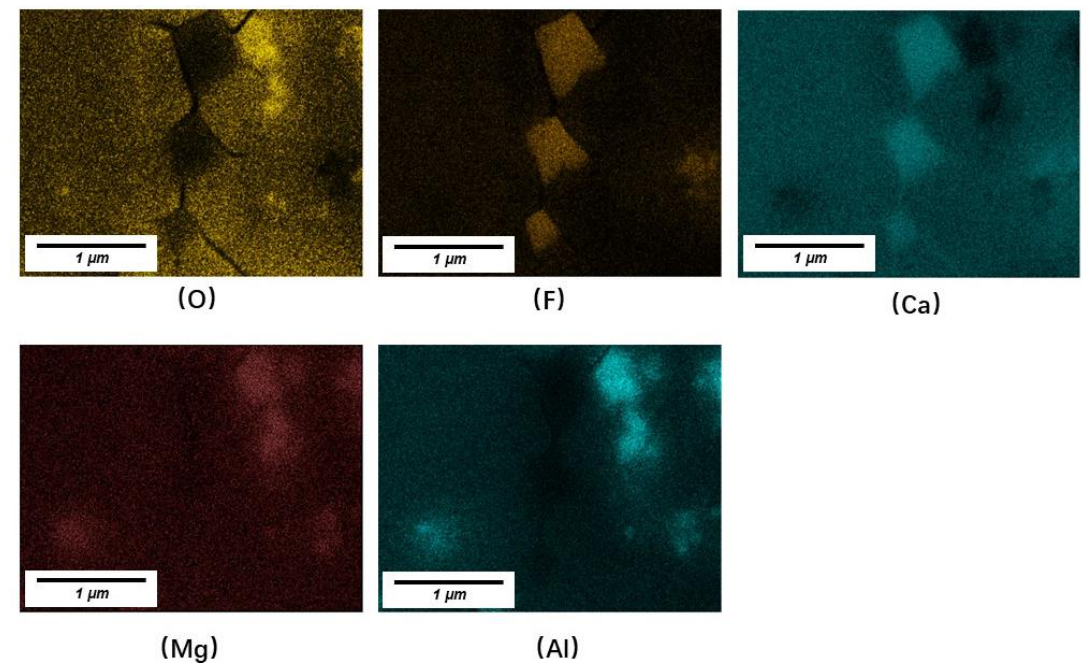
Figure 6. EDS mapping of CaF 2 and spinel (MgAl 2 O 4 ) crystals.